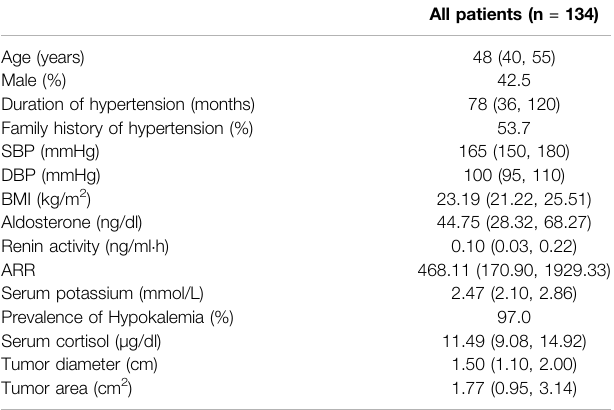
TABLE 1 | Clinical characteristics of the study population.